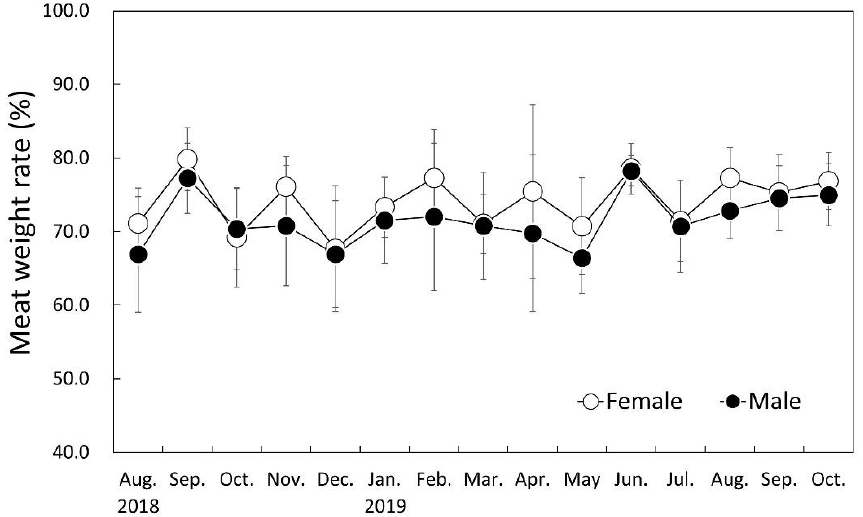
Figure 10. Monthly variations of meat weight rate (MWR) in Buccinum osagawai . Vertical bars indicate SD.